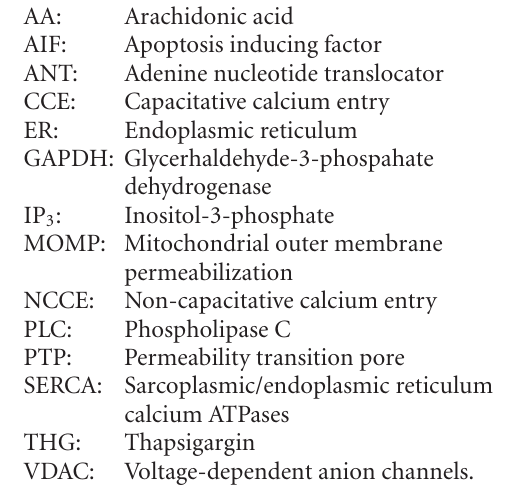
Figure 4: Ca 2+ signaling in survival and apoptosis versus deregula- tion of Ca 2+ homeostasis as necrogenic